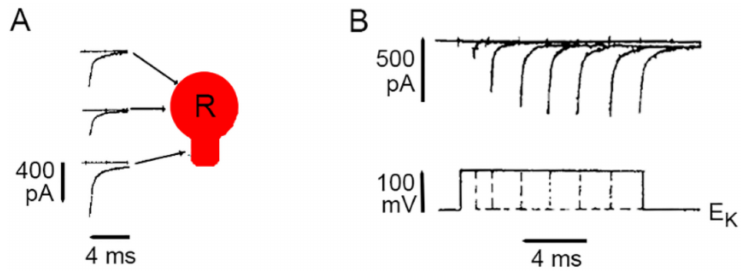
Figure 2. Calcium currents though L-type channels in the soma membrane. ( A ) Loose patch clamp recordings of calcium tail currents from small patches of membrane upon 10 ms depolarization. All recordings were obtained with the same pipette, thus making the amplitude of currents compara- ble for reflecting the density of active channels. ( B ) Lack of inactivation of somatic calcium current indicating predominant activation of L-type channels. The activation kinetics were reconstructed by superimposing tail currents upon depolarizations with increasing durations. Potassium tail currents were prevented by clamping the voltage at the potassium equilibrium potential (E K ). Sodium tail cur- rents were eliminated by reducing the sodium concentration in the pipette. Adapted with permission from the publisher of